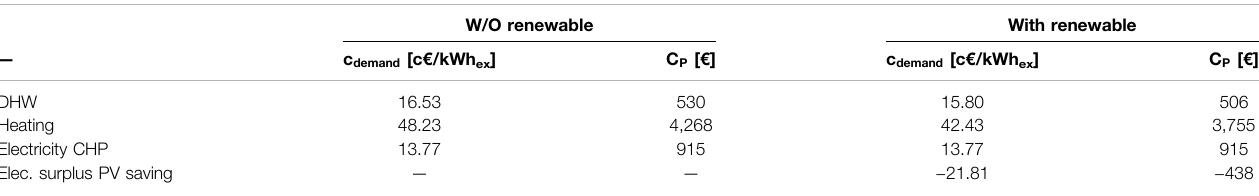
TABLE 6 | Exergoeconomic unit and total costs for products. W/O renewable With renewable